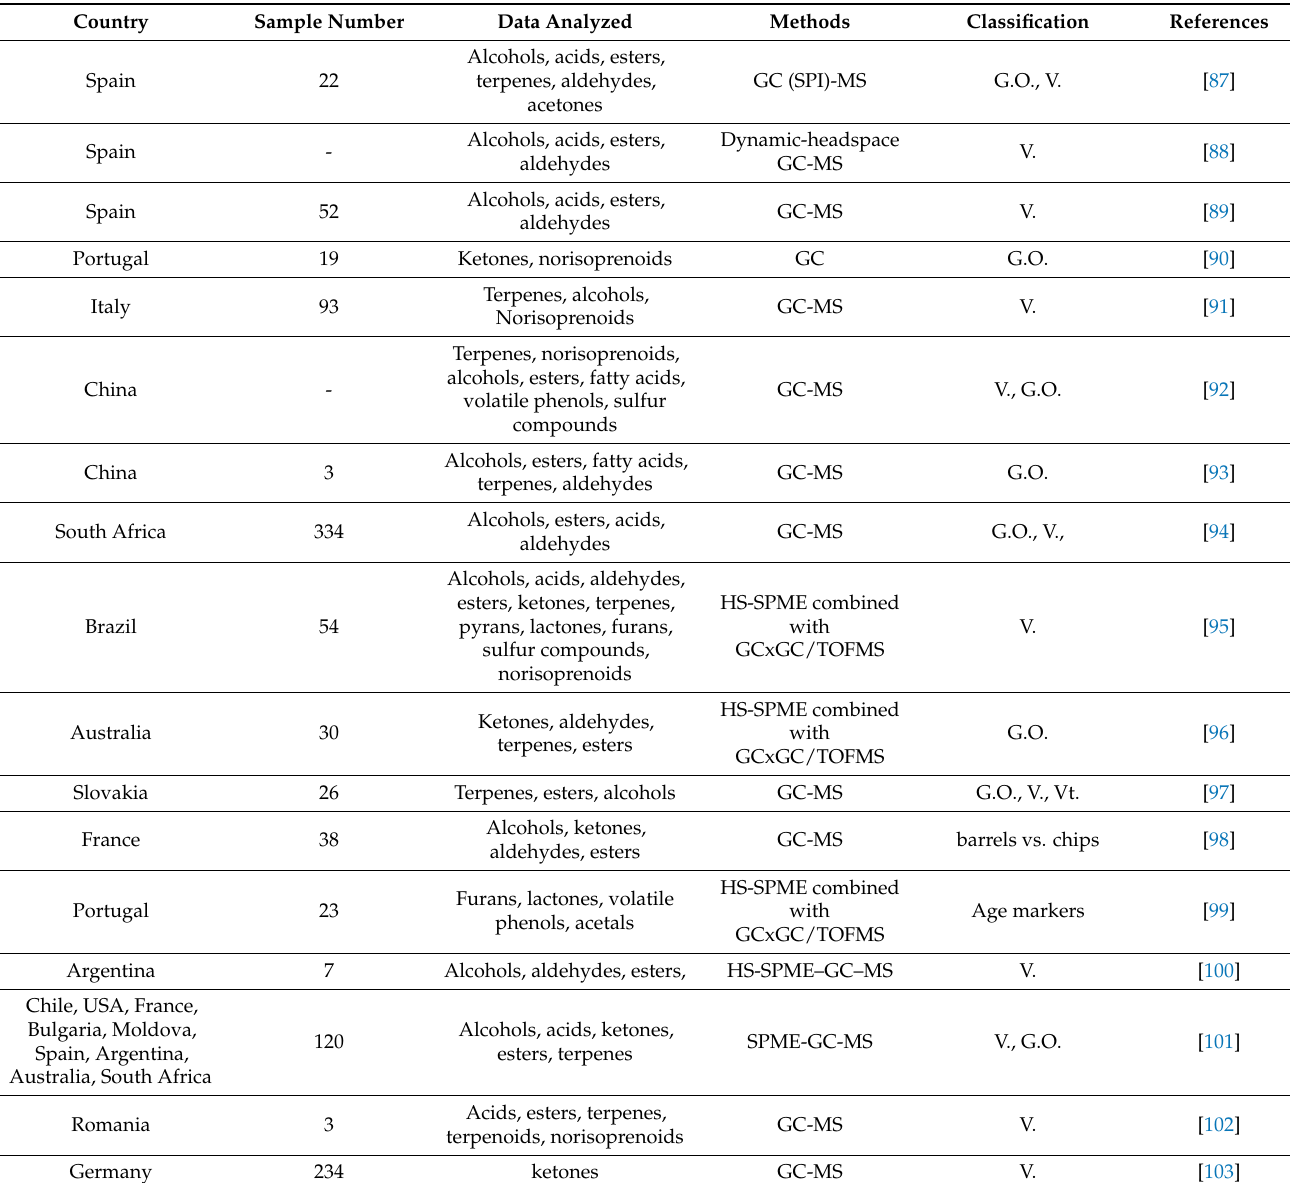
Table 3. Studies and analytical techniques to confirm the authenticity of wines based on the quantification of aroma